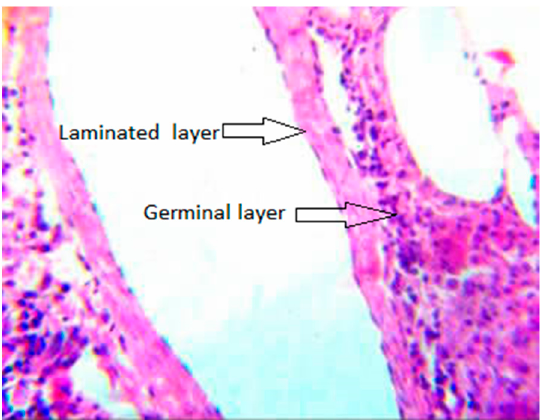
Figure 4. Liver pathology of sheep infected by E. granulosus (×400). Note the laminated layer ( → ) with a glue peptone like appearance in the germinal layer ( → ).